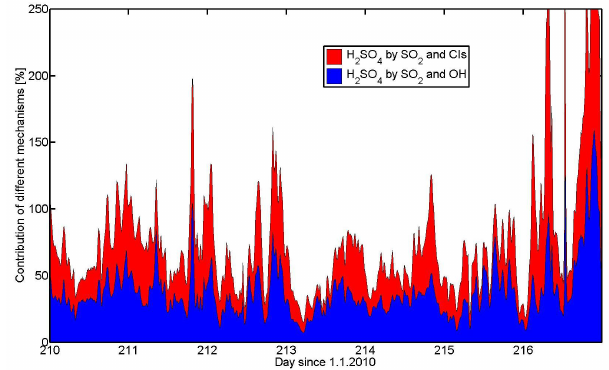
Fig. 8. Cumulative percentage contribution of the different SO 2 ox- idation mechanisms for